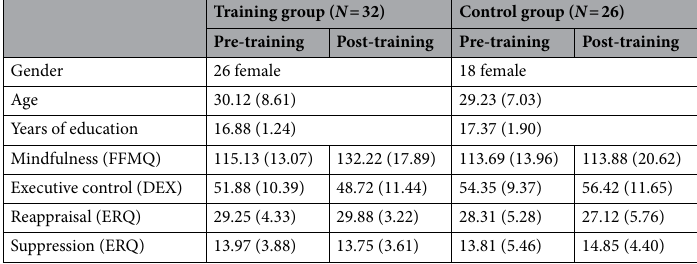
Table 1. Distributions of demographic and trait